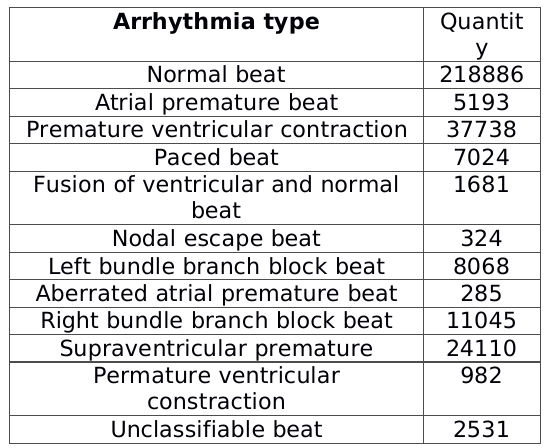
Fig. 3. The multi-input and single-output model structure for Arrhythmia classification.